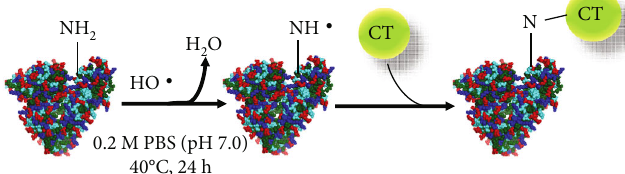
Figure 2: Schematic depiction of human serum albumin (HSA) conjugated with catechin